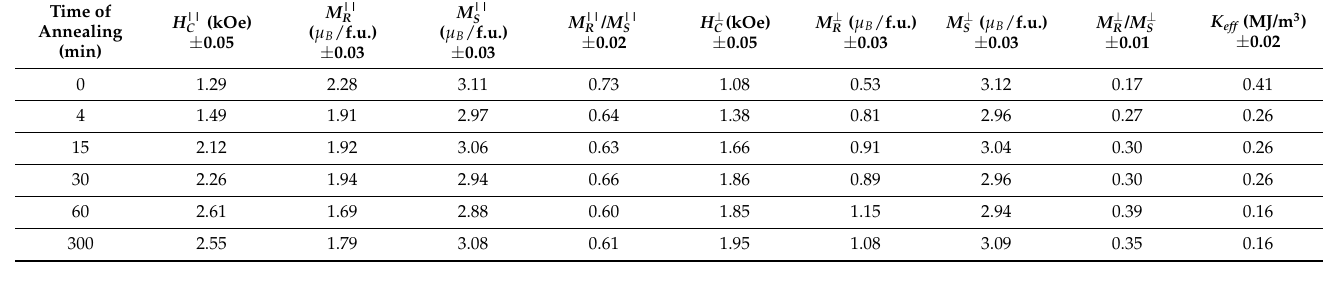
, loop squareness 𝑆